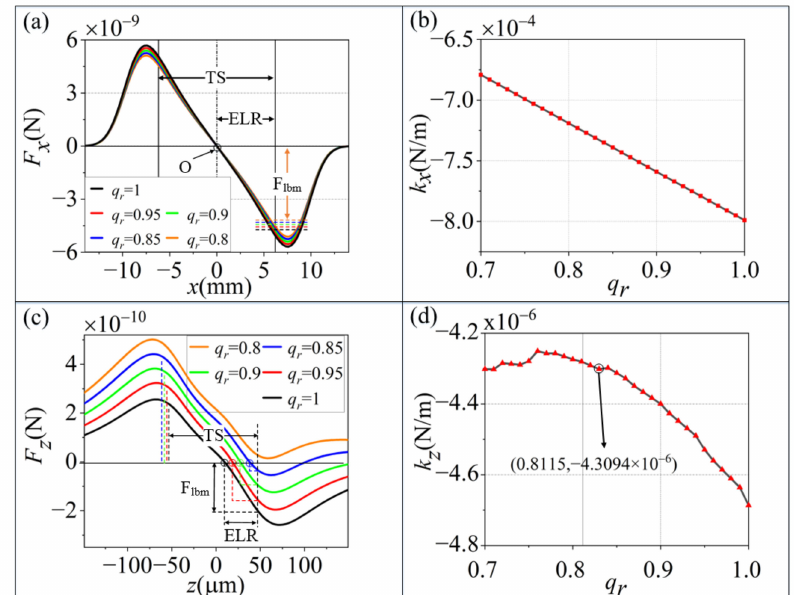
Figure 2. Optical forces on a sphere in a Gaussian dual-beam trap when q r changes from 0.8 to 1. O, optical force equilibrium position; TS, trapping scope; ELR, effective linear region; and F lbm , the minimum absolute force at the trapping scope borders. ( a ) is the relationships of gradient force F x and different q r values along the X axis. ( c ) is the relationships of scattering force F x and different q r values along the Z axis. ( b,d ) are the relationships of the trap stiffness and q r along the X and Z axes,